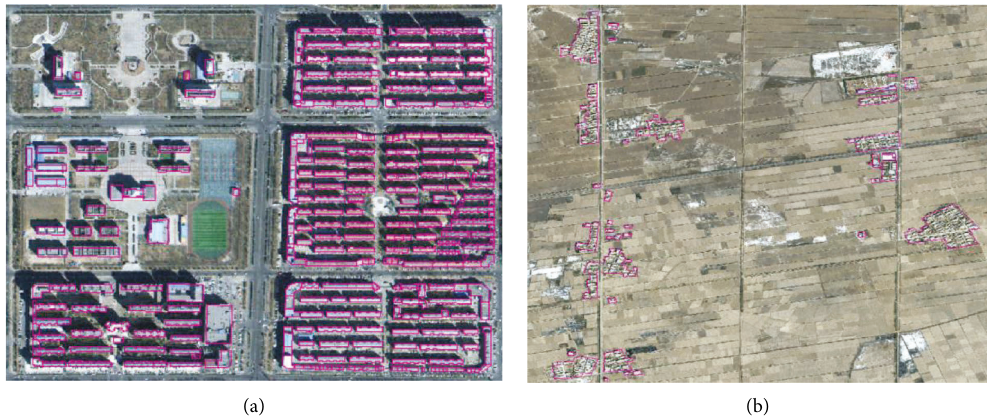
Figure 3: Standard maps of extracted building information for (a) an urban area and (b) a rural